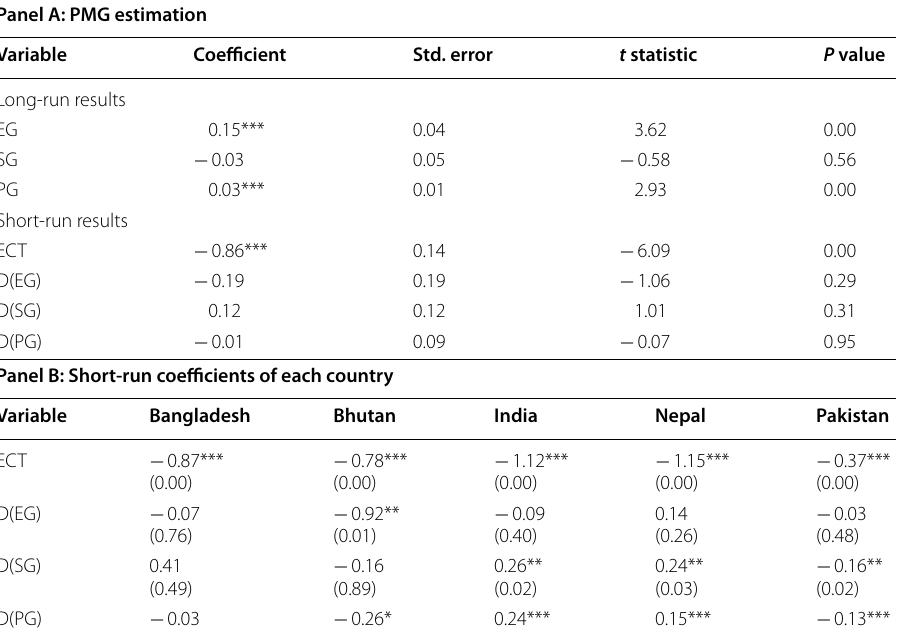
Table 4 PMG estimation of ARDL (1,1,1,1) for model 2 Panel A: PMG